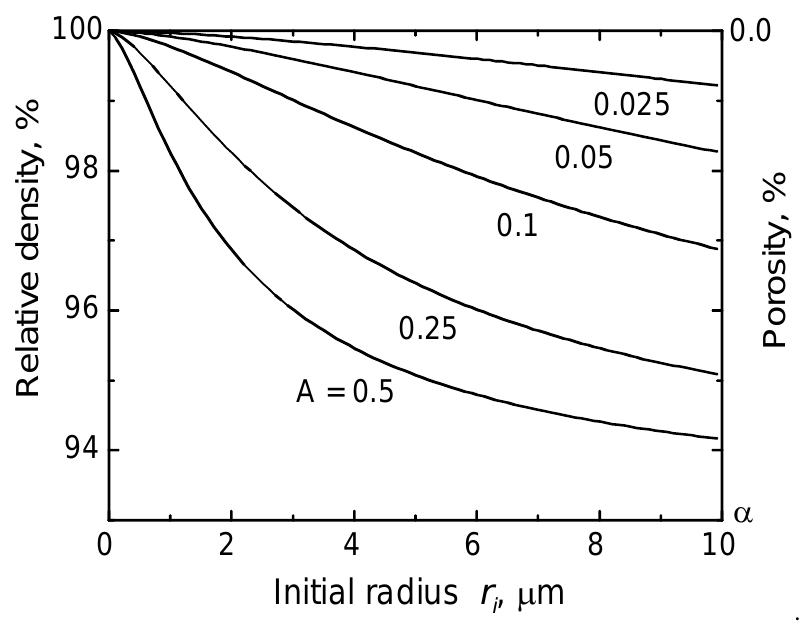
Figure 2. Maximum attainable density versus initial size of isolated pores, with initial porosity of α% [6] (reprinted with permission from Elsevier). The ordinate is scaled by assuming an initial density of 93% of the theoretical value. A = P i / 2 γ µ m − 1 .